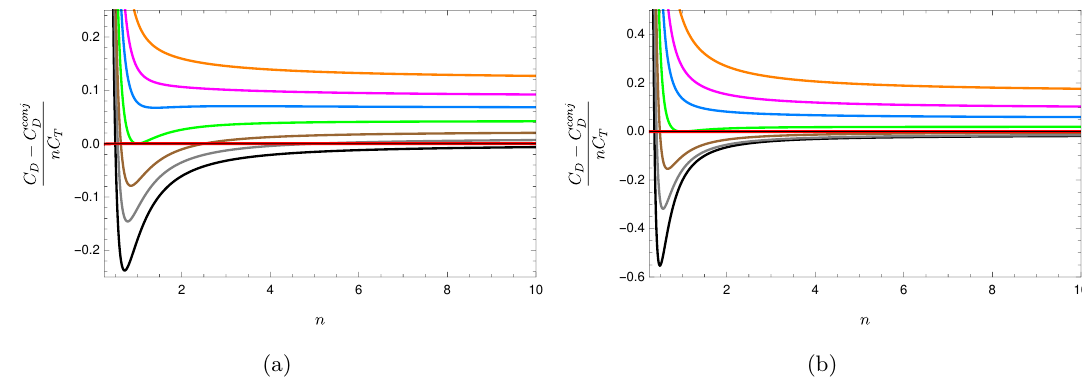
) / ( nC ) as a function of n for fixed chemical potential Figure 3 . Relative difference ( C D − C conj T D in d = 3 (left) and d = 4 (right). The different curves correspond to different chemical potentials, ˜ µ 2 = ± 0 . 09 , ± 0 . 16 , ± 0 . 25 , with ˜ µ 2 increasing from bottom to top (we set ‘ = 1 ). We plot ∗ /L the curve with ˜ µ = 0 in green. Note that ˜ µ 2 can be negative, as the chemical potential can take imaginary values. The red curve corresponds to evaluating the SUSY solution. As it can be seen, in this case C is exactly C conj , at least up to numerical errors of the order 10 − 4 in d = 3 and 10 − 6 D D in d = 4